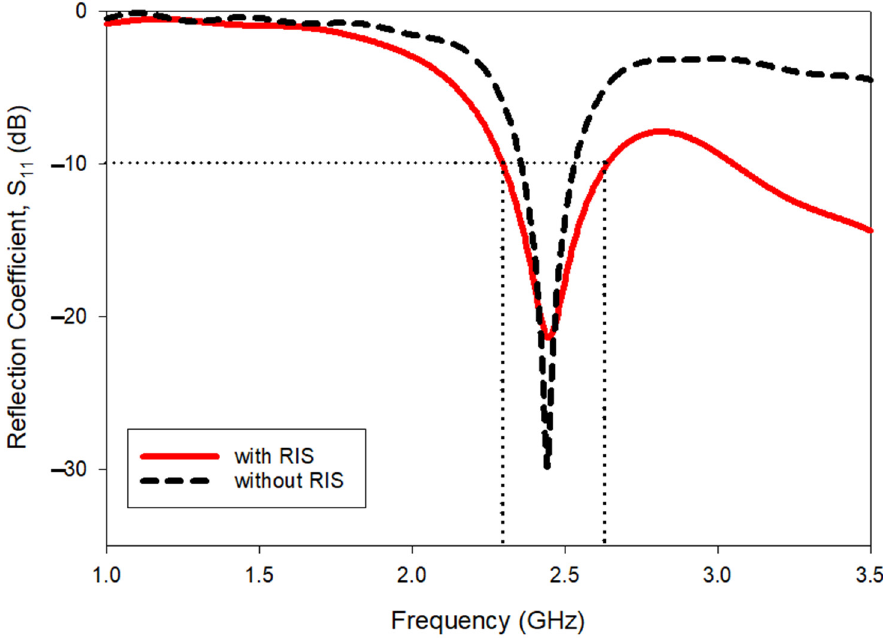
Figure 8. Reflection coefficient result comparison for MPA without RIS and with RIS.